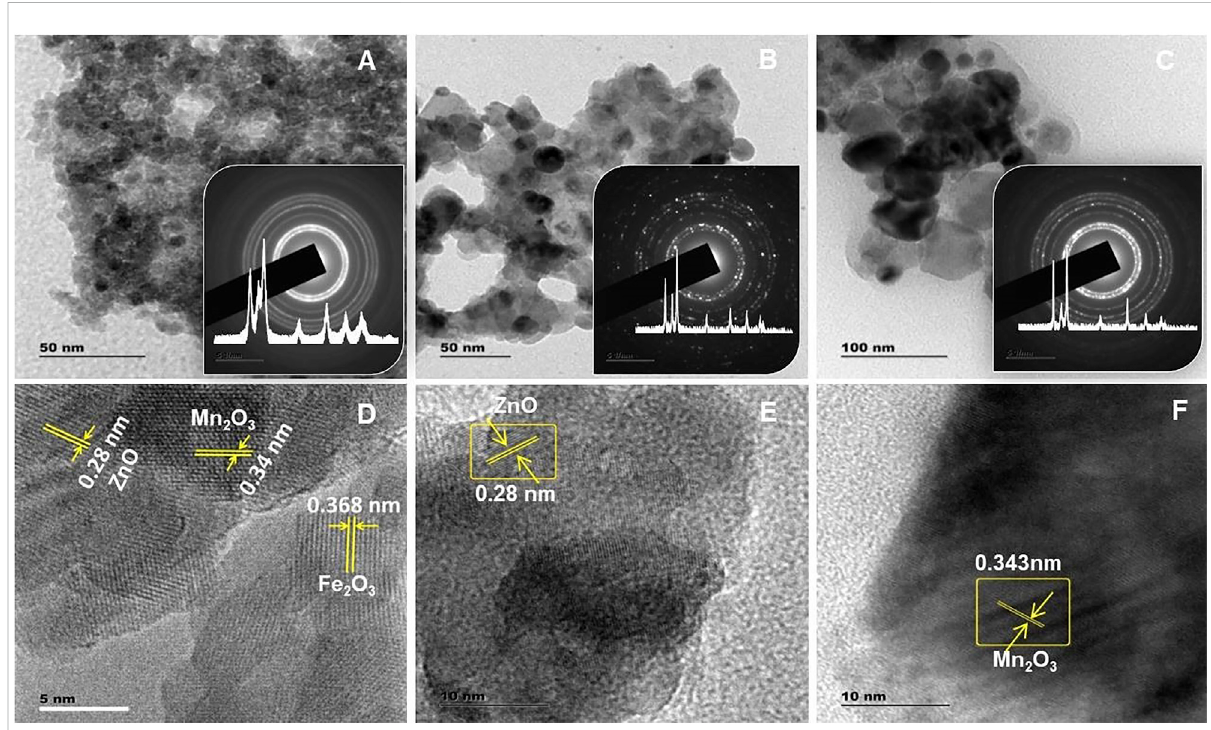
FIGURE 6 (A – C) Transmission electron microscopy images of PTP1, PB1, and PB2 NCs, respectively (inset: x-ray diffraction pattern and selected area electron diffraction rings). (D – F) the respective high-resolution transmission electron microscopy images (Inset: Inverse fast Fourier